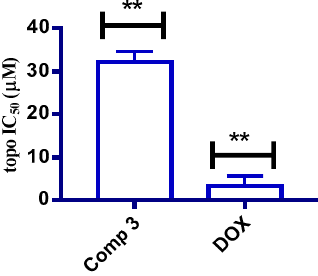
Figure 3. Graphical representation for comparison of topo II β IC 50 of compound 3 and Dox; topo II was performed using four doses protocol for compound 3 and Dox, and the concentration that induced 50% maximum inhibition of topo II was determined from sigmoidal dose–response. Data are one-way analysis of variance (ANOVA) followed by Tukey’s multiple comparison test (** p <